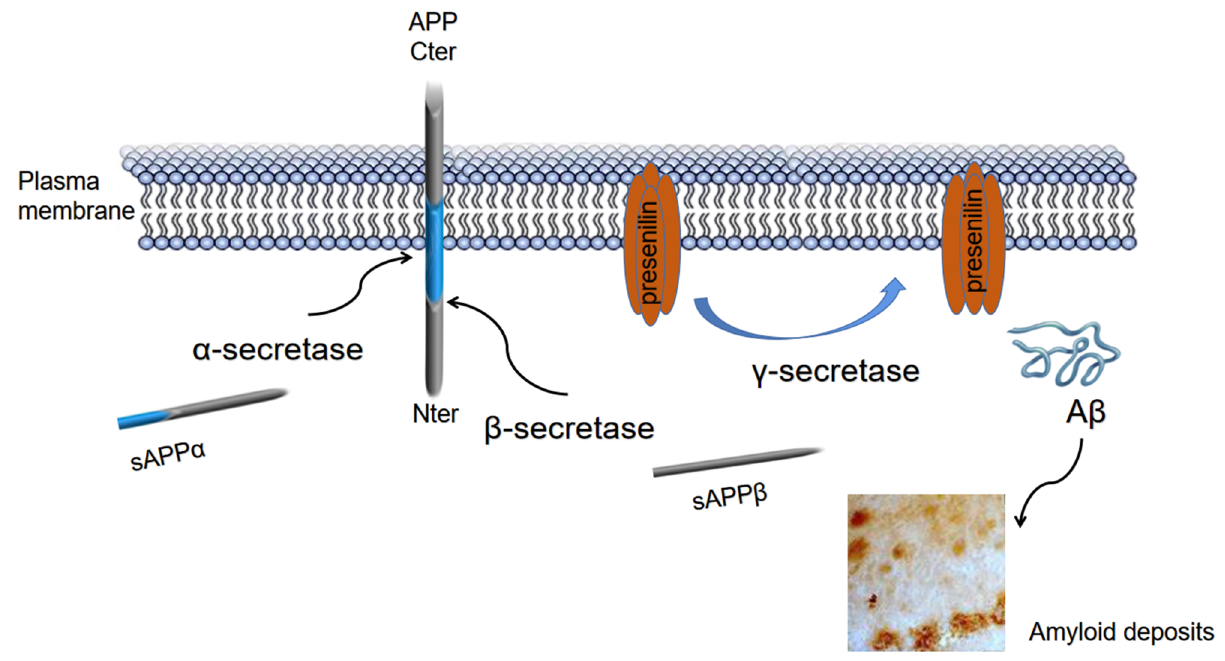
Figure 2. APP’s structure and Aβ processing by α-, β-, and